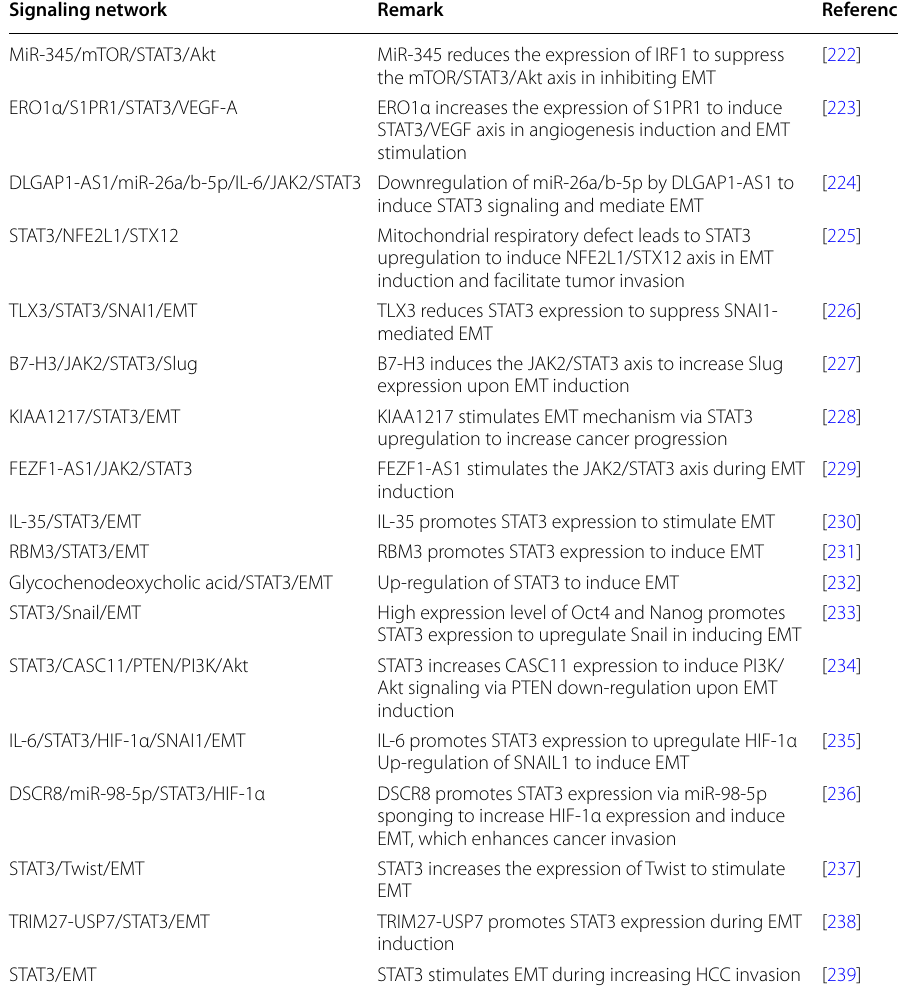
Table 2 The regulation of EMT mechanism by STAT3 in HCC cells Signaling